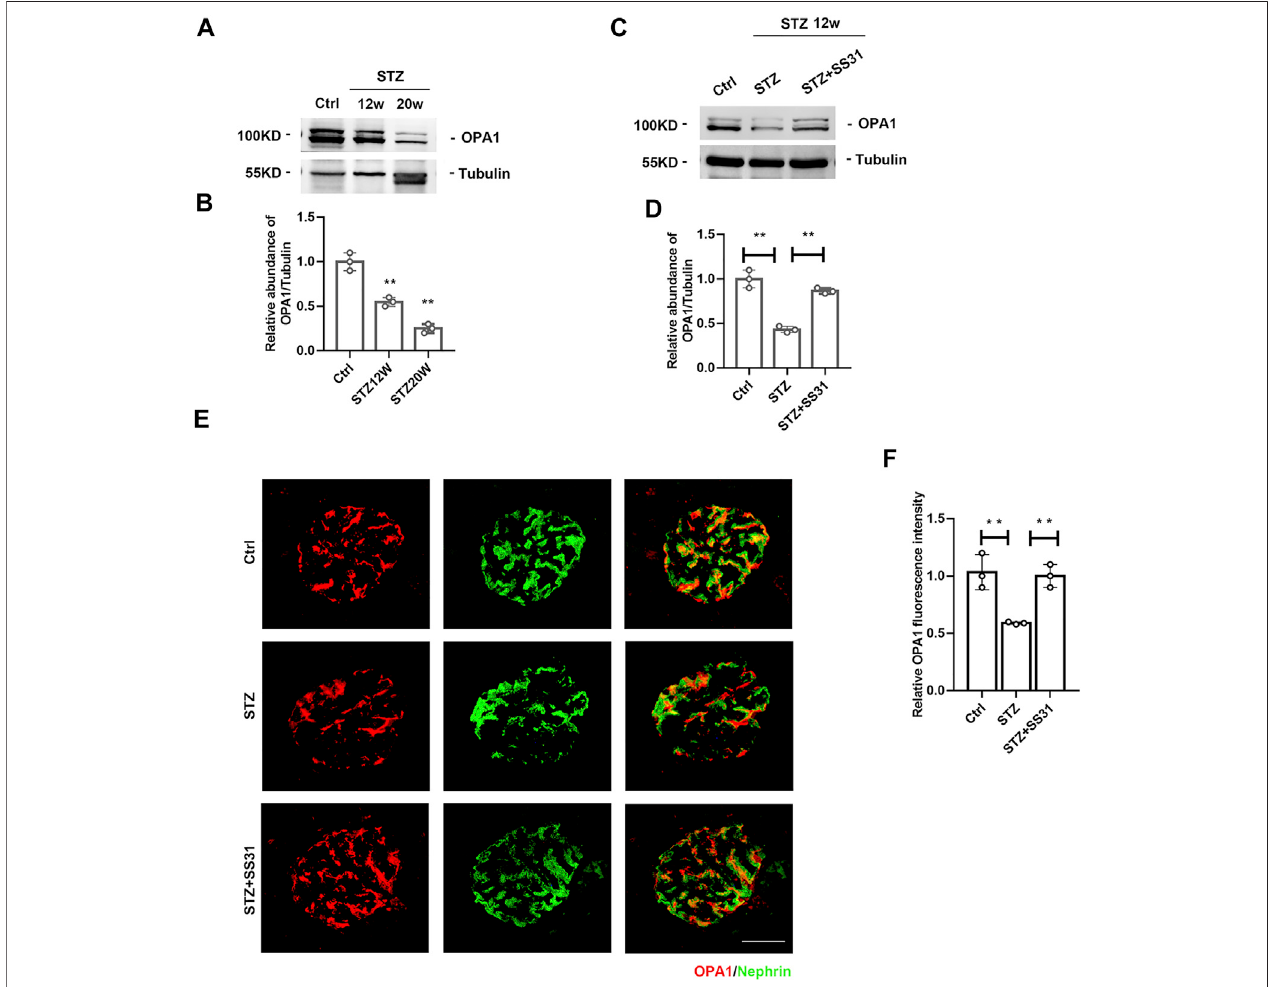
FIGURE 4 | SS31 inhibits STZ-induced downregulation of OPA1 in podocytes. (A) Western blot analysis showing glomerular OPA1 expression in mice after STZ injectionfor12and20 weeks (B) Semi-quantitativedensitometryanalysisforOPA1expression.n (cid:1) 3.** p < 0.01: p (cid:1) 0.004(CtrlvsSTZ12w), p (cid:1) 0.002(CtrlvsSTZ20w). (C) Western blot analysis showing glomerular OPA1 expression in diabetic mice with or without SS31 treatment. (D) Semi-quantitative densitometry analysis for OPA1 expression. n (cid:1) 3. ** p < 0.01: p (cid:1) 0.002 (Ctrl vs STZ), p (cid:1) 0.0012(STZ vs STZ + SS31). (E) Representative immuno fl uorescent images showing OPA1 and Nephrin staininginglomerulifromdiabeticmicewithorwithoutSS31treatment(Bar (cid:1) 10 μ m). (F) Semi-quantitativedensitometry analysisforOPA1 fl uorescenceintensity.n (cid:1) 3. ** p < 0.01: p (cid:1) 0.007 (Ctrl vs STZ), p (cid:1) 0.002(STZ vs STZ +